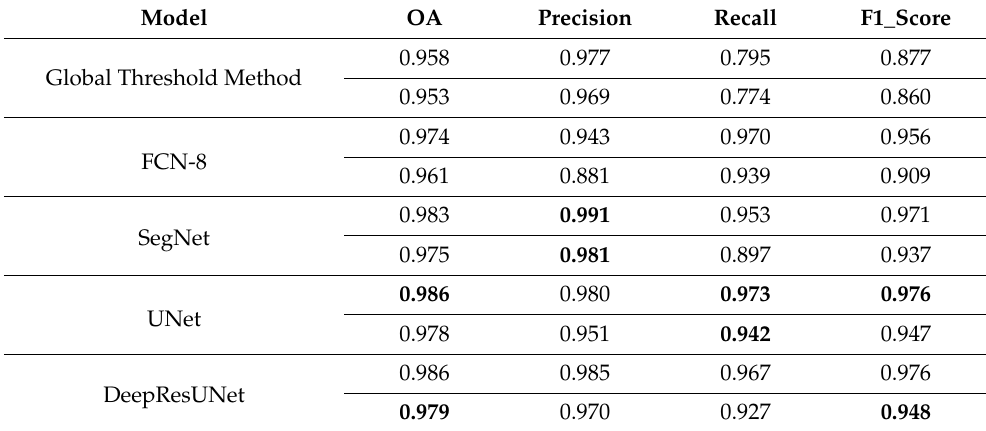
Table 3. Comparisons of model performances with two different test datasets. The first line presents the models’ performances with test dataset 1, and the second with test dataset 2. The values in bold indicate the highest numbers for corresponding metrics. Model OA Precision Recall F1_Score Global Threshold